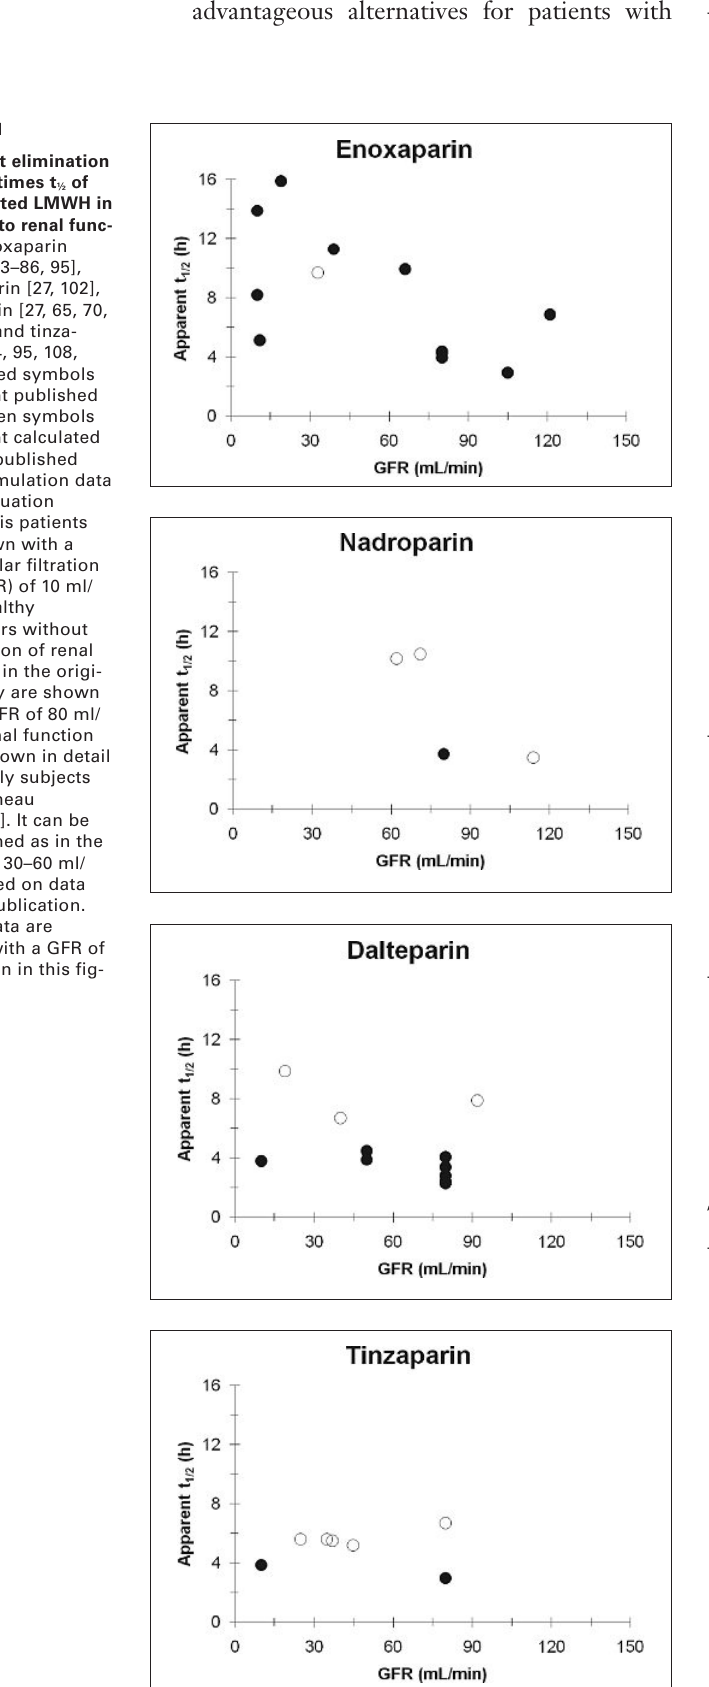
Apparent elimination half-life times t ½